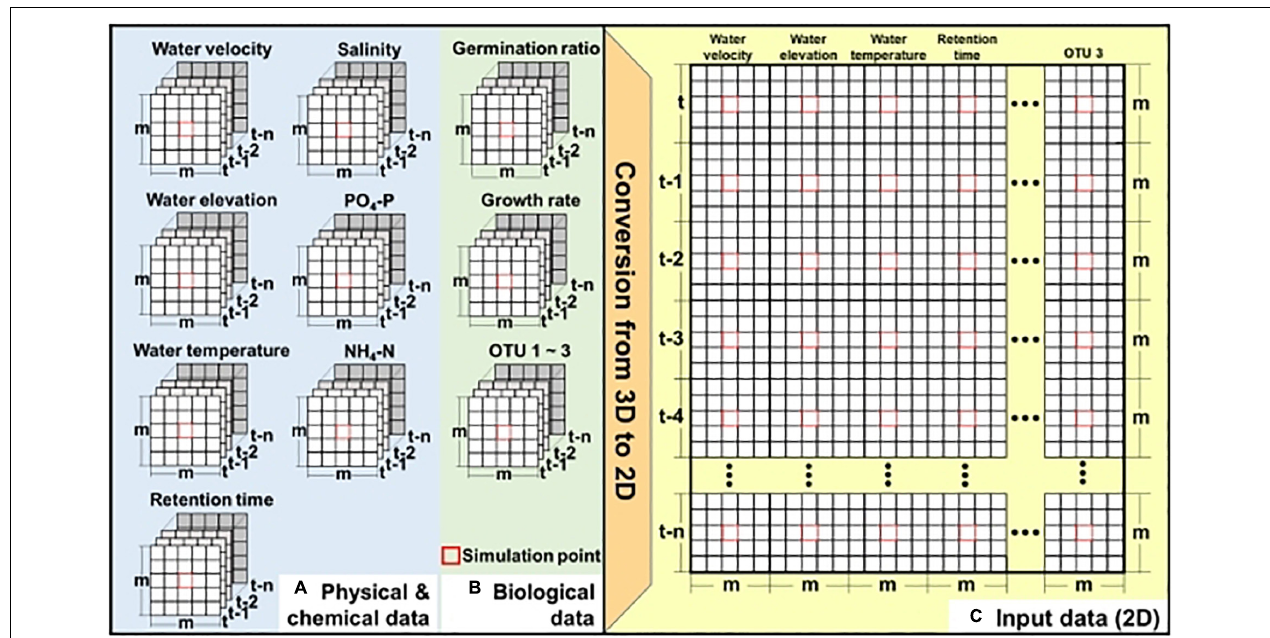
FIGURE 2 | Preparation of input data for CNN— (A) physical and chemical data obtained using EFDC, (B) biological data obtained using EFDC and linear equation, and (C) two-dimensional input data. Here, m denotes the input window (i.e., height × width), including the simulation point located at the center of input window while n denotes the lookback size. Red boxes indicate the simulation